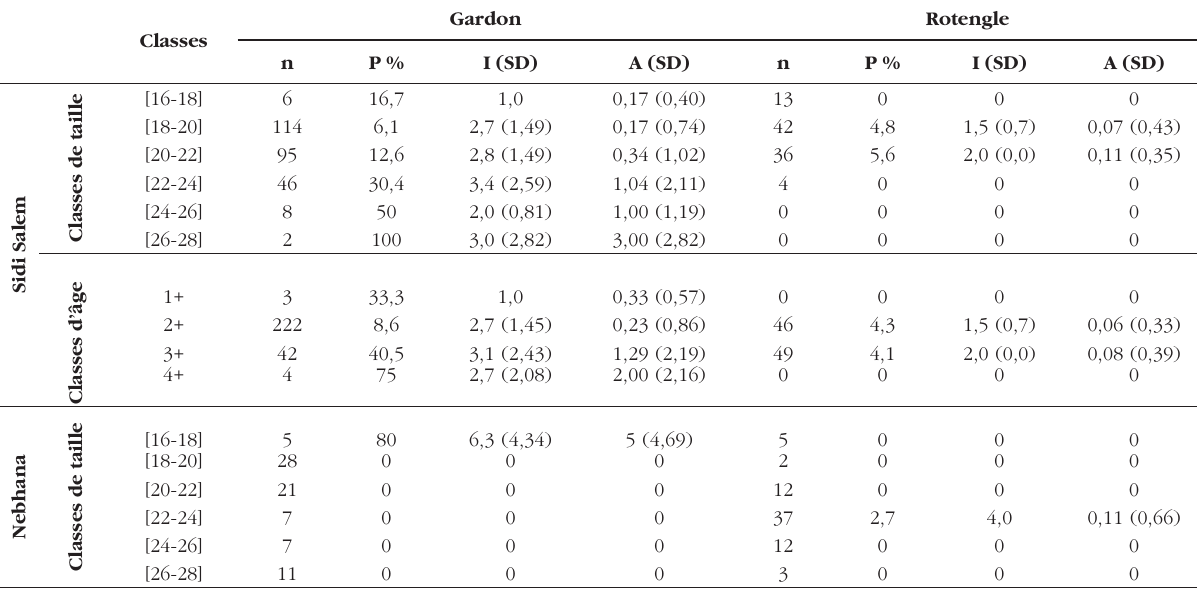
Tableau II. – Paramètres épidémiologiques de la ligulose en fonction de la taille et de l’âge des gardons et des rotengles récoltés dans les retenues de barrages de Sidi Salem et de